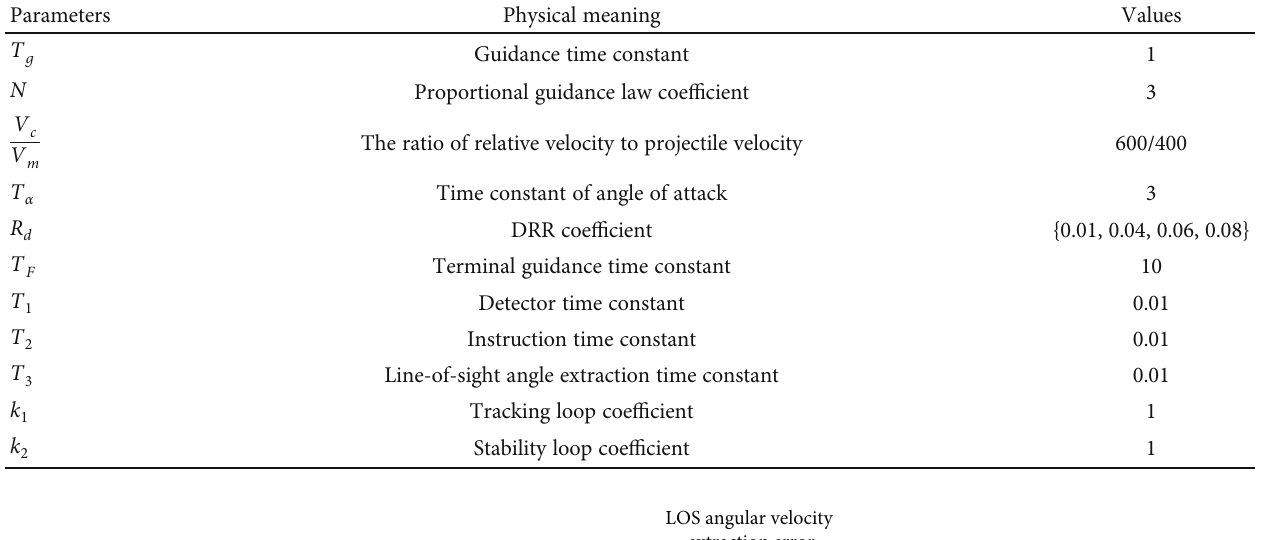
Table 2: Simulation parameters.